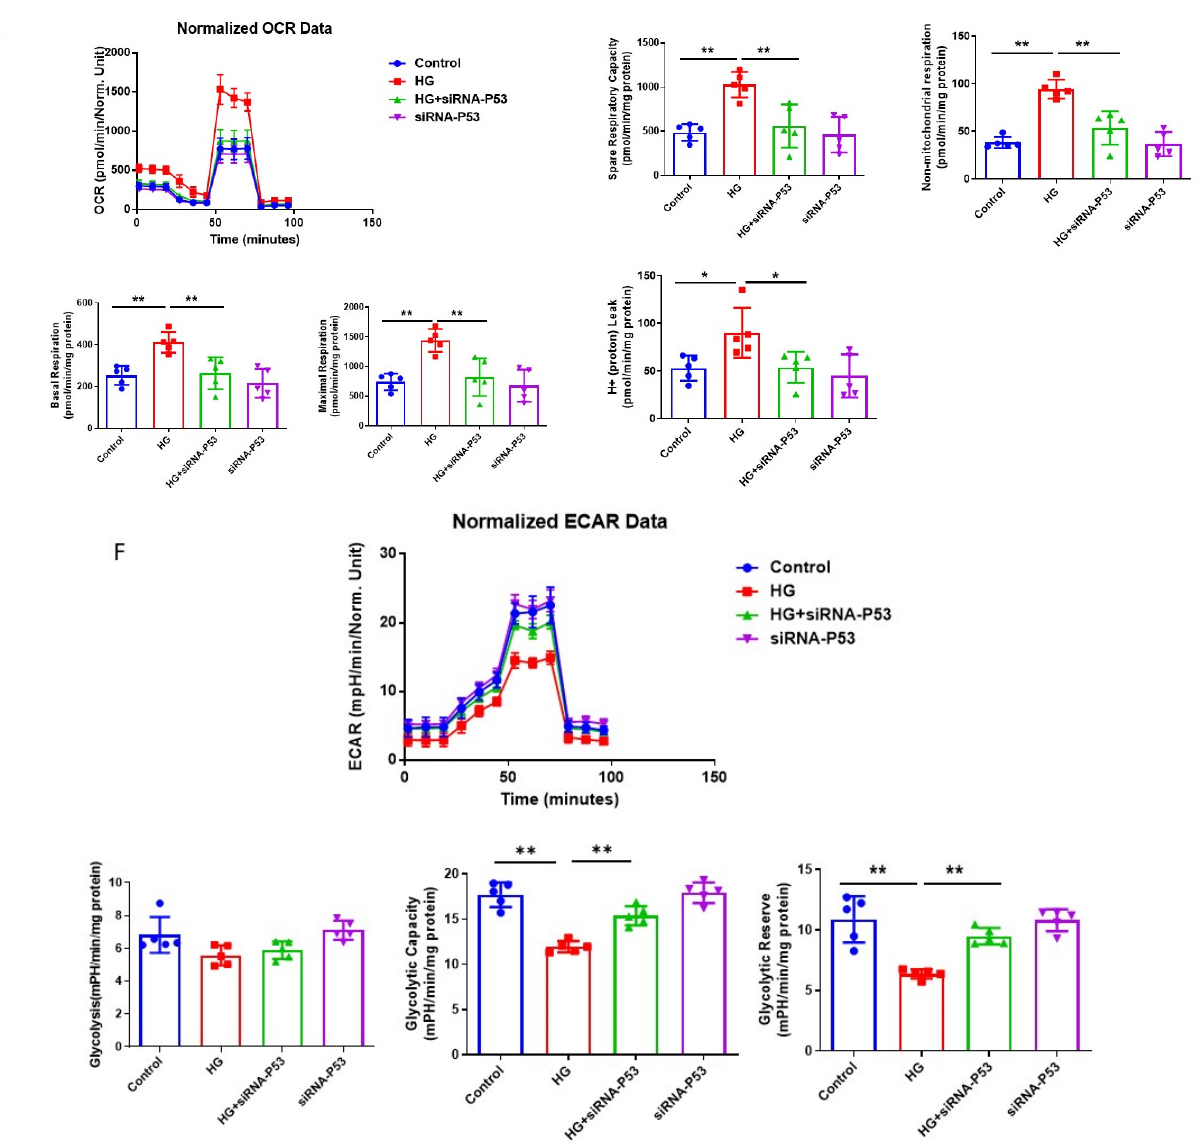
Figure 3. Knockdown of p53 ameliorates HG-induced disruption of PHDs-HIF- α signaling and improves metabolic metabolism in H9c2 cells. ( A ) Exposure of H9c2 cells to different concentra- tions of glucose (15, 30, 45 mM) for 72 h resulted in a dose-dependent increase in p53 levels as compared to normal glucose (5.5 mM). Densitometries showed a signi fi cant upregulation of p53 expression at 30 mM and 45 mM concentrations. Data represent mean ± SD (n = 3 per group, * p < 0.05 and ** p < 0.01). ( B ) Knockdown of p53 resulted in suppression of HG (30mM)-induced upregulation of PHD1 and PHD2. Data represent mean ± SD (n = 3 per group, * p < 0.05 and ** p < 0.01). ( C ) Knockdown of p53 increased the expression of HIF-1 α and HIF-2 α in H9c2 cells under HG (30 mM) conditions. Data represent mean ± SD (n = 3 per group, * p < 0.05 and ** p < 0.01). ( D ) Knockdown of p53 upreg- ulated the expression of Ang-1 and VEGF and downregulated TGF- β expression under HG (30mM) conditions. Data represent mean ± SD (n = 3 per group, * p < 0.05 and ** p < 0.01). ( E ) Knockdown of p53 a tt enuated HG (30mM)-induced increases in basal respiration, maximal respiration, spare res- piration, non-mitochondrial respiration, and proton leak in H9c2 cell lines. All data represent mean ± SD (n = 5, * p < 0.05 and ** p < 0.01). ( F ) Knockdown of p53 rescued HG (30mM)-induced impair- ments of glycolytic capacity and glycolytic reserve in H9c2 cell lines. All data represent mean ± SD (n = 5, ** p < 0.01). Circle, square and triangle were denoted the di ff erent experiment groups as indi- cated in the fi gures.